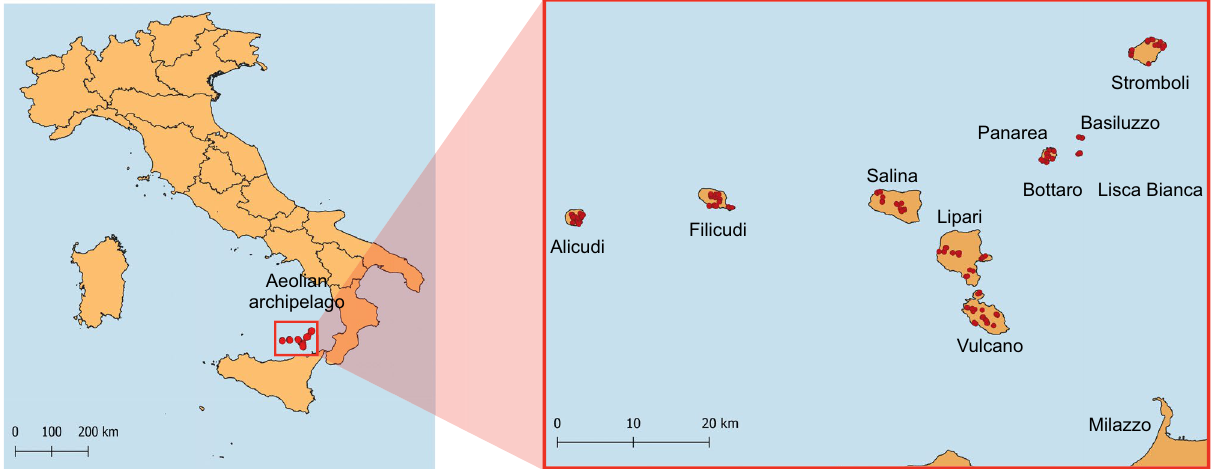
Figure 1. Study area in the Aeolian archipelago and sampling locations of the 408 sampled individuals (red dots). Lisca Bianca and Bottaro islets are geographically close and points are partially overlapped. The map was created using QGIS 68 .